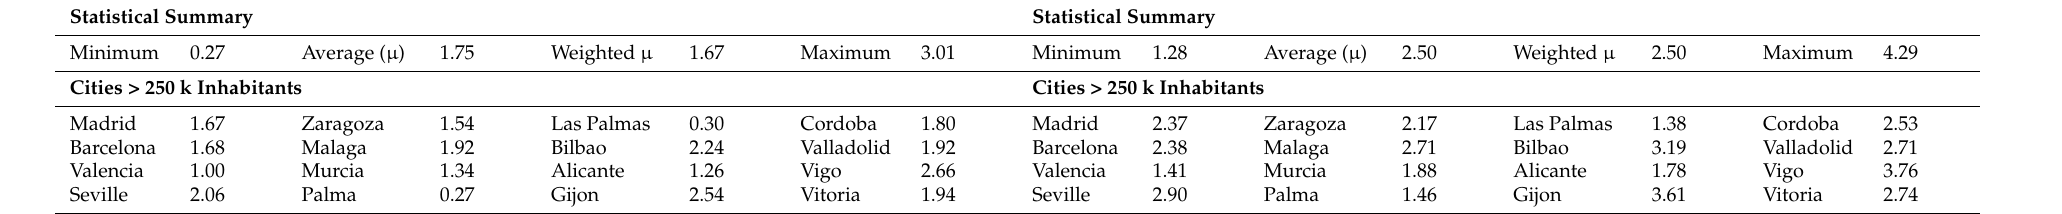
Figure A7. ST EB in years (S3 (auxiliary electricity supply scenario) left , and S4 (auxiliary natural gas supply scenario) right ).